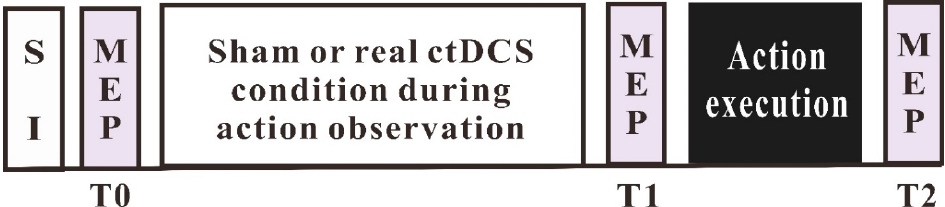
Figure 1. Timeline of the experimental protocol.